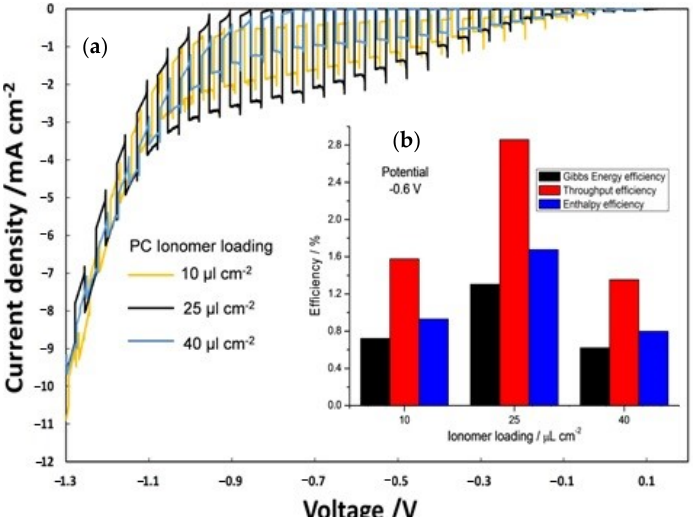
Figure 7. ( a ) On–off polarization curves by varying ionomer loading at photocathode; ( b ) efficiency versus photocathode ionomer content.